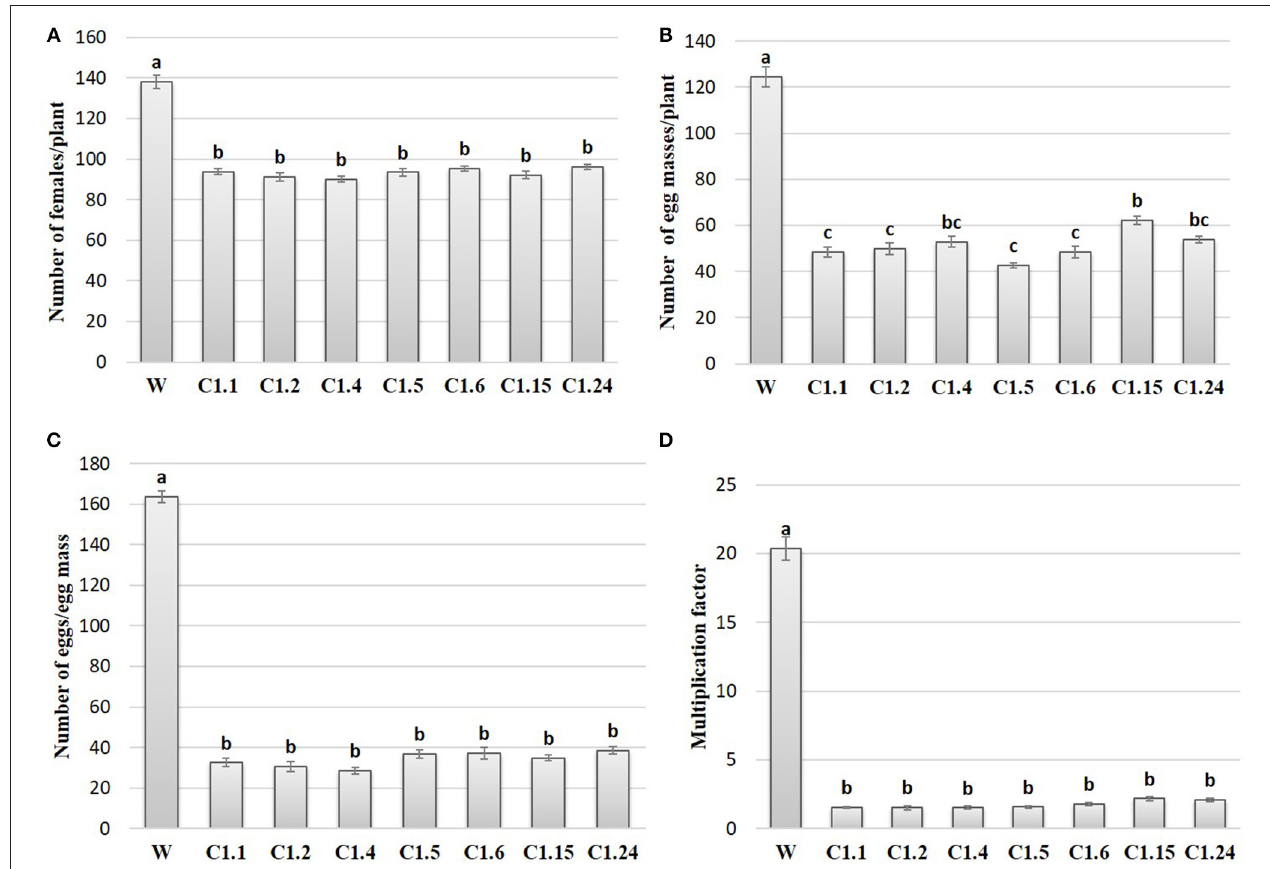
FIGURE 7 | Effect of host generated RNAi of Mi-col-1 on (A) relative number of females/plant; (B) egg masses/plant; (C) eggs/egg mass; and (D) multiplication factor in transgenic tomato events (C1.1, C1.2, C1.4, C1.5, C1.6, C1.15, and C1.24) and wild type (W) tomato plants after 35 days of inoculation. Each bar represents mean ± standard error of six different plants of each event. Bars with different letters indicate statistically significant difference between the treatments ( P < 0.05) according to Tukey’s test (Tukey’s HSD).